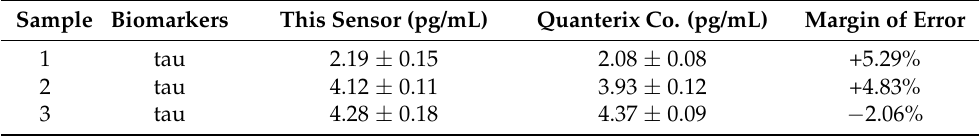
Table 2. Determination of tau in clinical samples and a comparison between our sensor and Quanterix Co., Ltd.